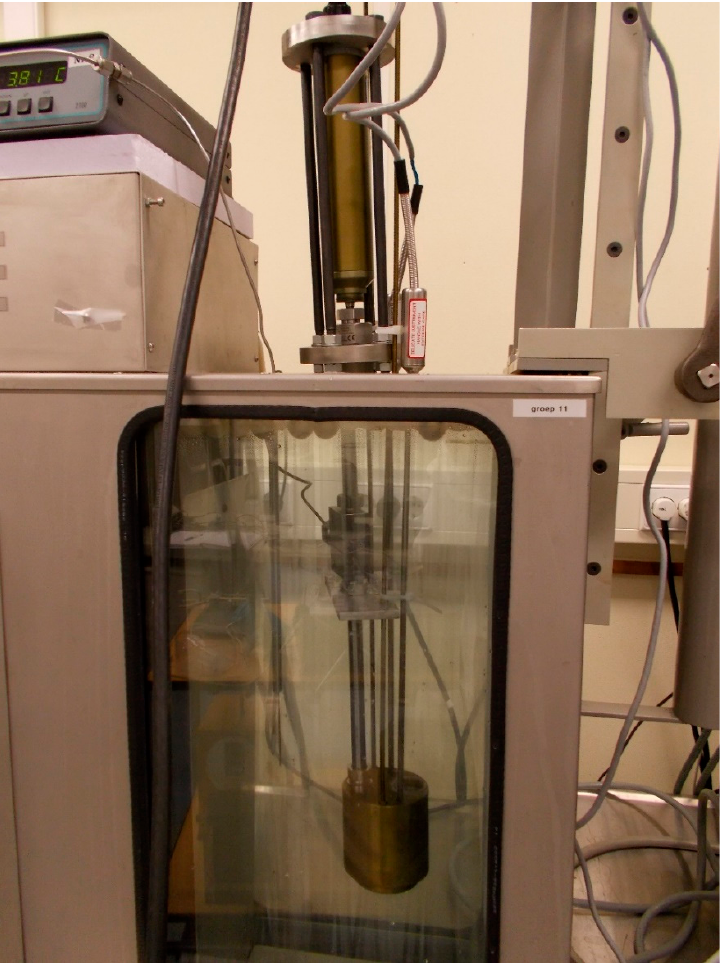
Figure 7. Experimental set-up for the temperature–pressure calibration of SBE35 units. As expected from thermodynamic considerations, the pressurization and de-pressurization of the pressure enclosure affected the temperature of the SBE35, due to the temperature change of the pressure-transmitting hydraulic liquid generated by the pressure